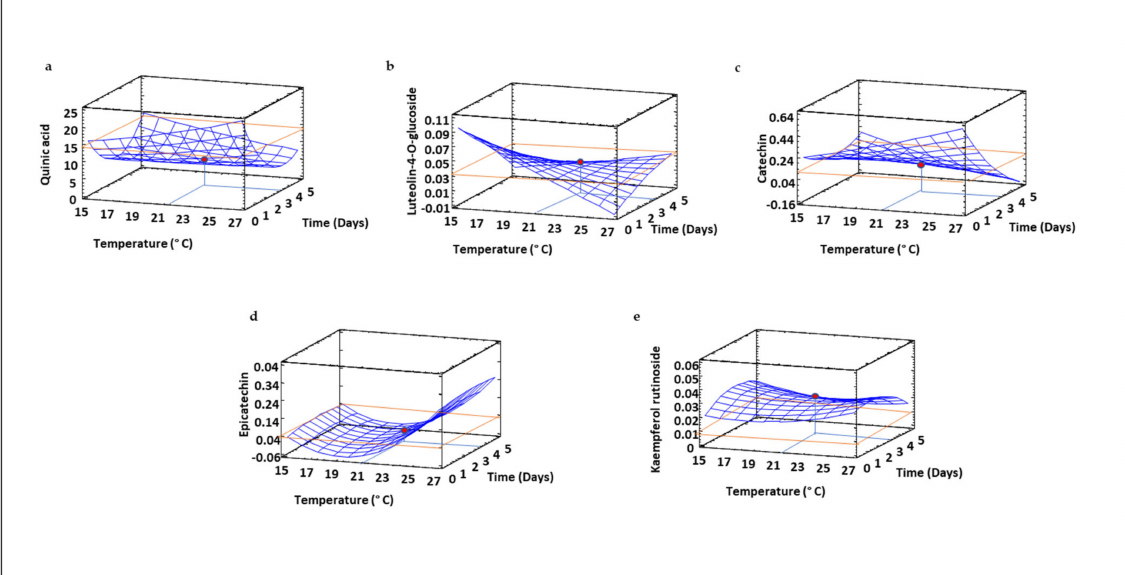
Figure 8. Three-dimensional response surface plots for the content ( µ g mg − 1 ) of soluble phenolic ( µ g/mg) compounds determined using High-performance liquid chromatography (HPLC) coupled to a tandem quadrupole mass spectrometer: Quinic acid ( a ), Luteolin-4- O -glucoside ( b ), Catechin ( c ), Epicatechin ( d ), and Kaempferol rutinoside ( e ) as a function of the interaction between germination temperature and time. The red line corresponds with the control (ungerminated seed) and the red point with the value for optimum conditions (21 ◦ C and 3.5